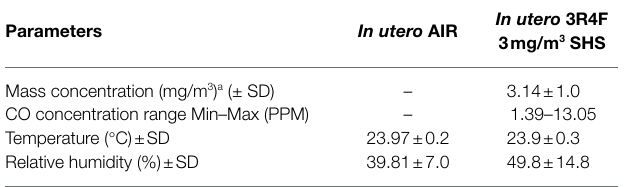
TABLE 1 | In utero SHS + elastase – Emphysema study. Parameters